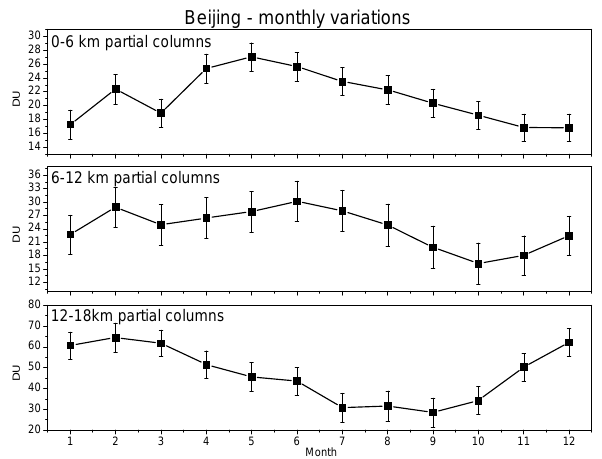
Figure 6. Percentage of cloud free and ozone quality flagged IASI pixels per month for the 3 regions for the year 2008.